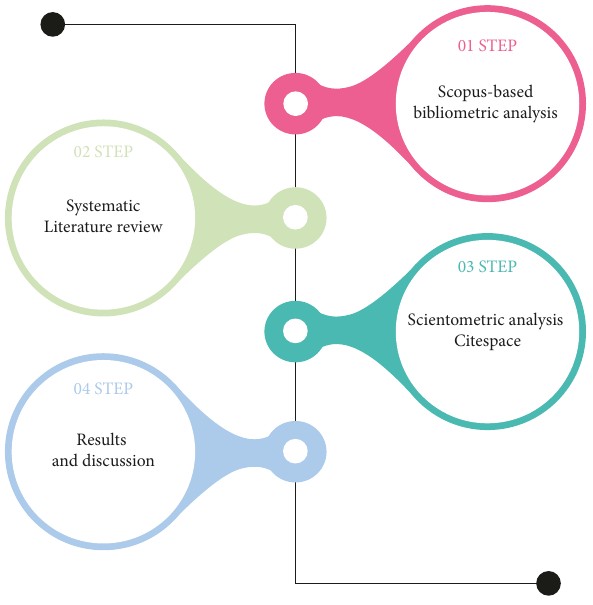
Figure 1: Research